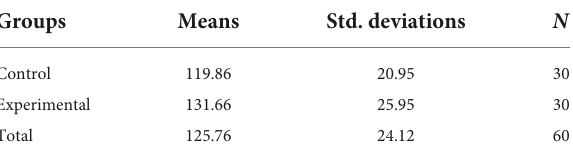
TABLE 3 Descriptive statistics of both groups on the motivation post-tests.